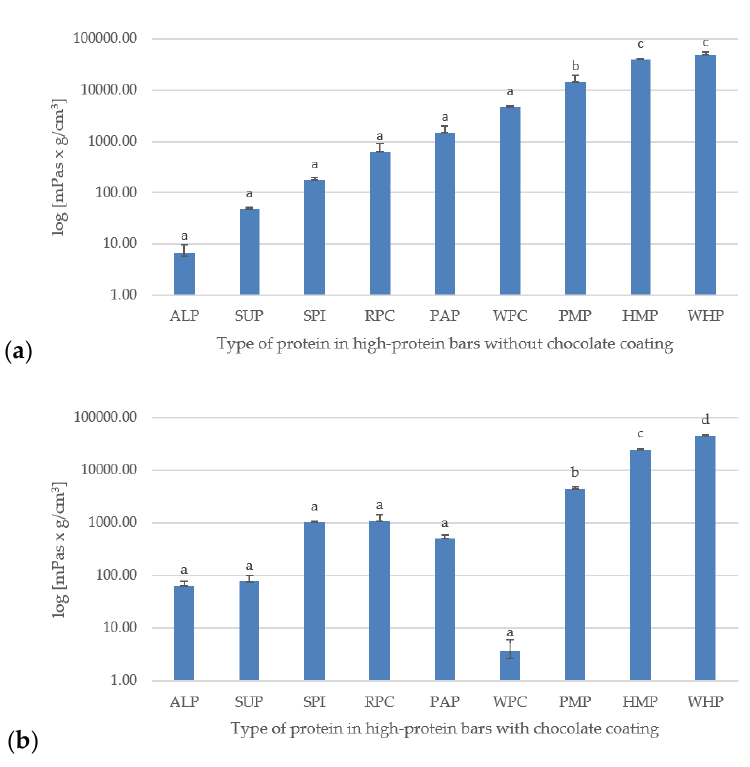
Figure 3. ( a ) Ultrasonic viscosity measurement results (mPas g/cm 3 ) of tested high-protein bars without chocolate coating; ( b ) With chocolate coating. Letters (a–d) indicate significant differences at p < 0.05 (Tukey’s HSD test).